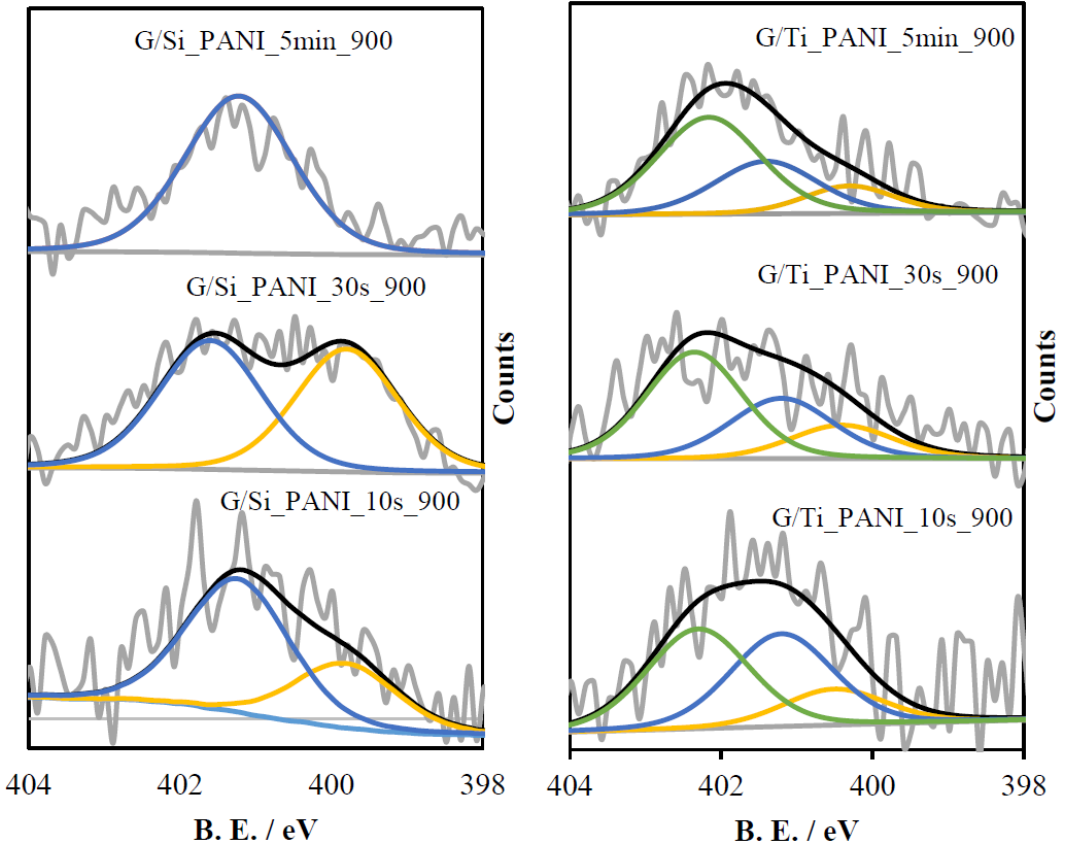
Figure 5. N1s spectra of all heat-treated G/Si-PANI-X-900 and G/Ti-PANI-X-900 samples.